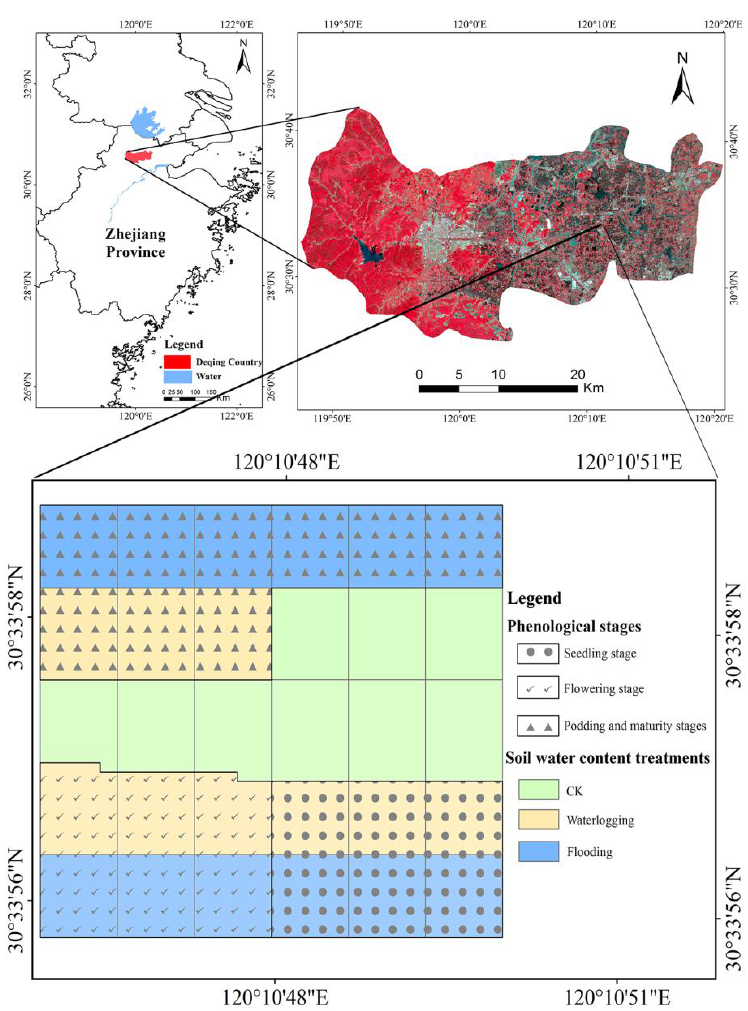
Figure 1. Experiments designed from October 2014 to May 2015 at the Deqing study site, Zhejiang, China. Background maps were color composite GF-1 acquired on 12 May 2015, with the (RGB) band combination = bands 4, 3, 2.